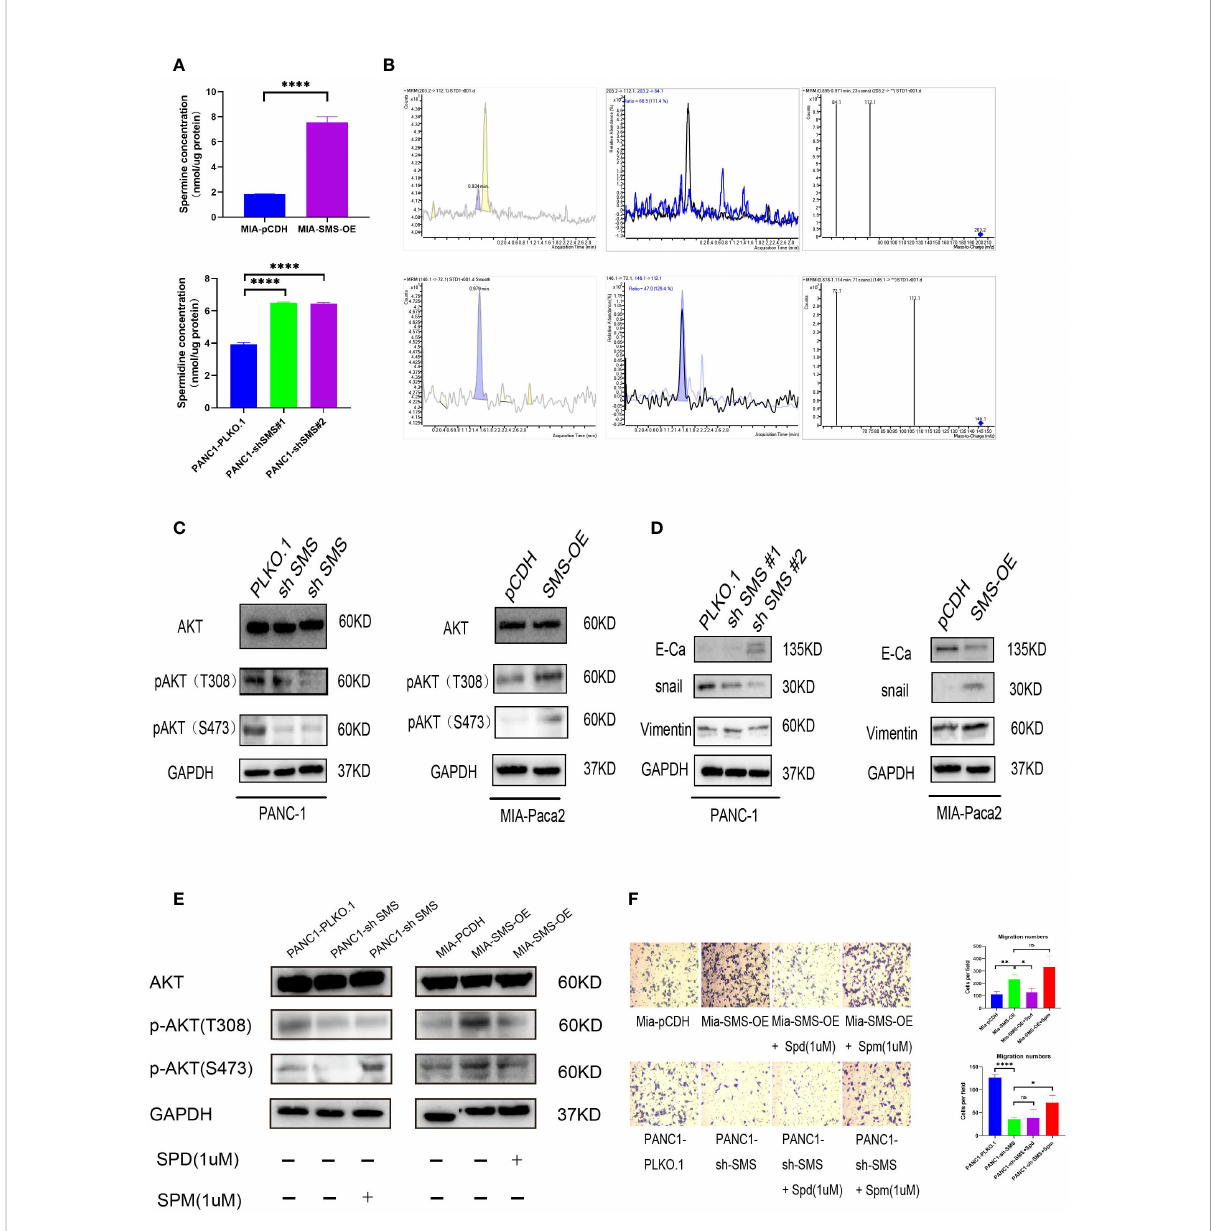
FIGURE 3 SMS promotes pancreatic cancer metastasis is mediated through the AKT/EMT signaling pathway. (A) SMS metabolizes spermidine to spermine. The levels of spermidine (SPD), and spermine (SPM) in SMS-OE or SMS-knockdown Mia-Paca2 and PANC1 cells were determined by LC-MS. (B) Mass spectrometry images of spermidine and spermine detection. (C, D) The protein expressions of AKT and EMT pathway were analyzed. (E) Spermidine/spermine could rescue the expression of AKT phosphorylation. (F) Spermidine/spermine could rescue the migration ability of overexpressed/knockdown SMS-stable cells by transwell assay. *P < 0.05; **P < 0.01; ****P < 0.0001. ns, no signi fi